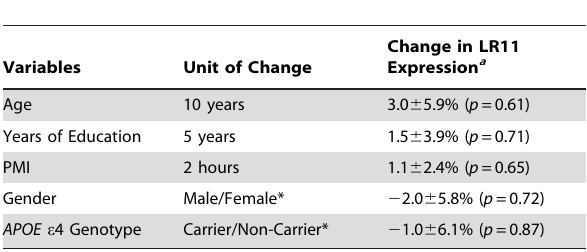
Table 3. Frontal cortex LR11 is not associated with any clinical variables.